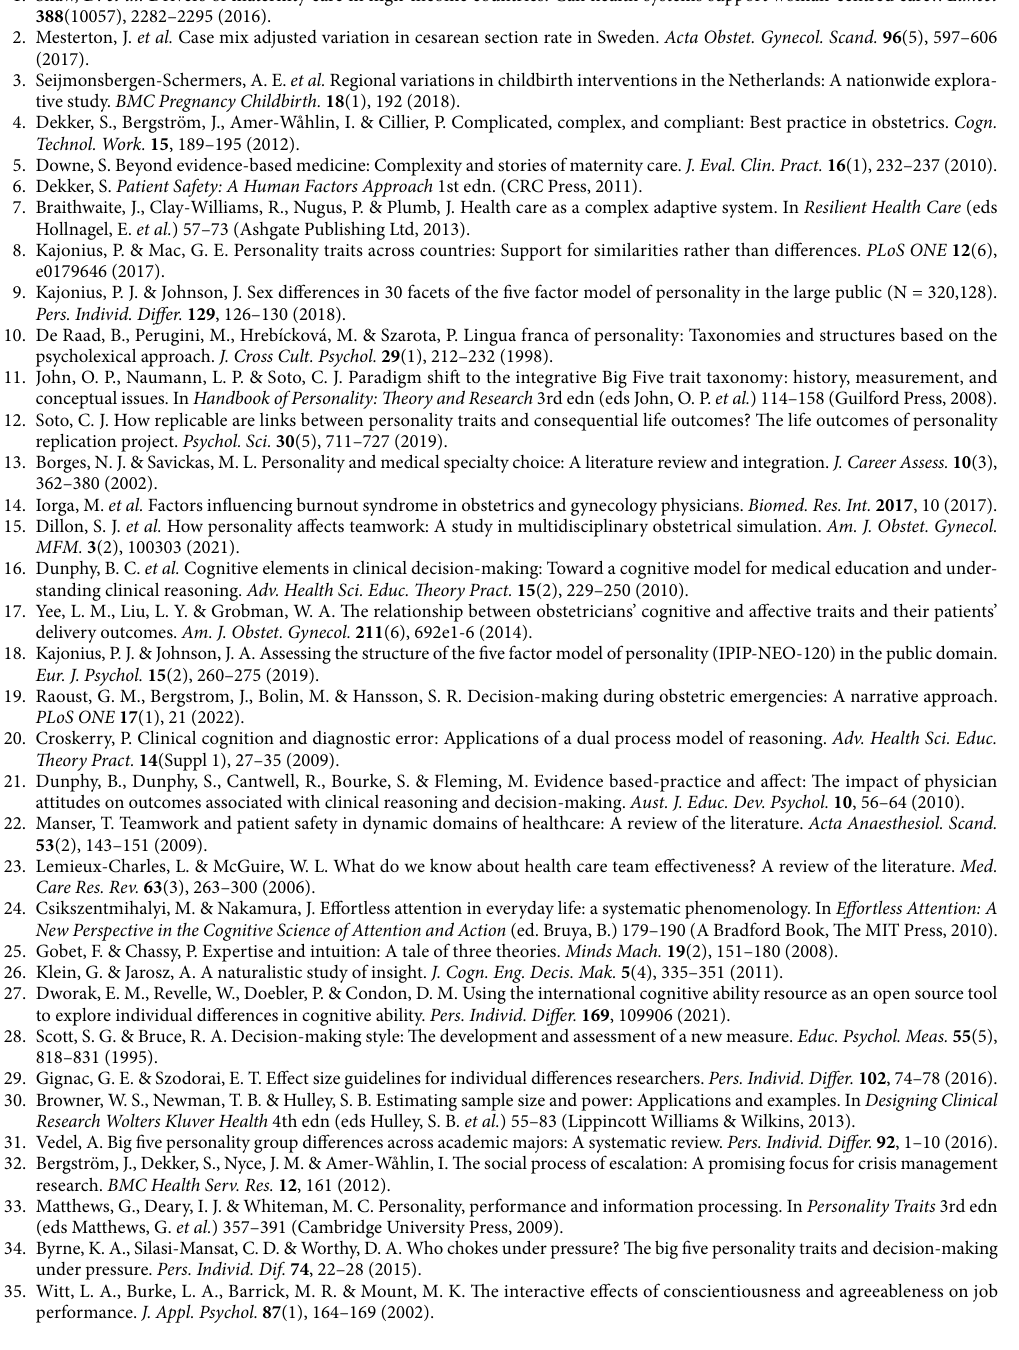
Table 3. Common method variance, which is the tendency of participants to somewhat agree with items, might also have confounded the results somewhat 43 . This effect is likely only in parity with the smallest correlation (r = 0.09), found between decision-making styles. Further explorations regarding the role of personality traits in decision-making styles during childbirth emergencies is